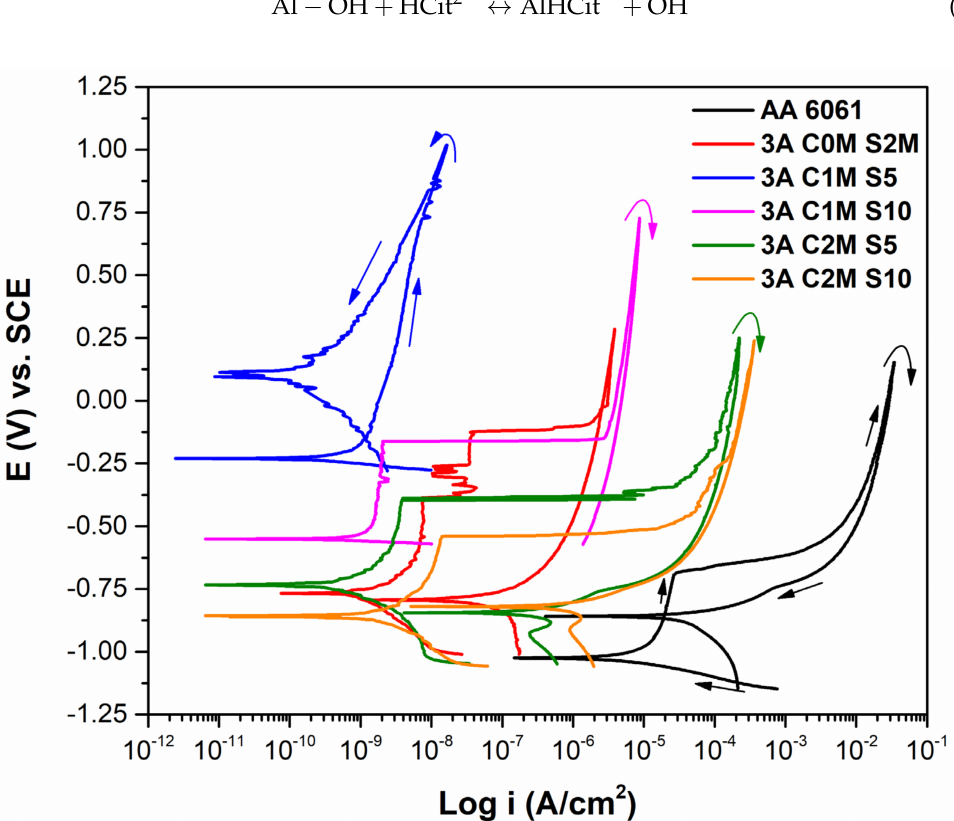
Figure 7. CPP curves of the AA6061 samples a 3 A/dm 2 in NaCl solution.